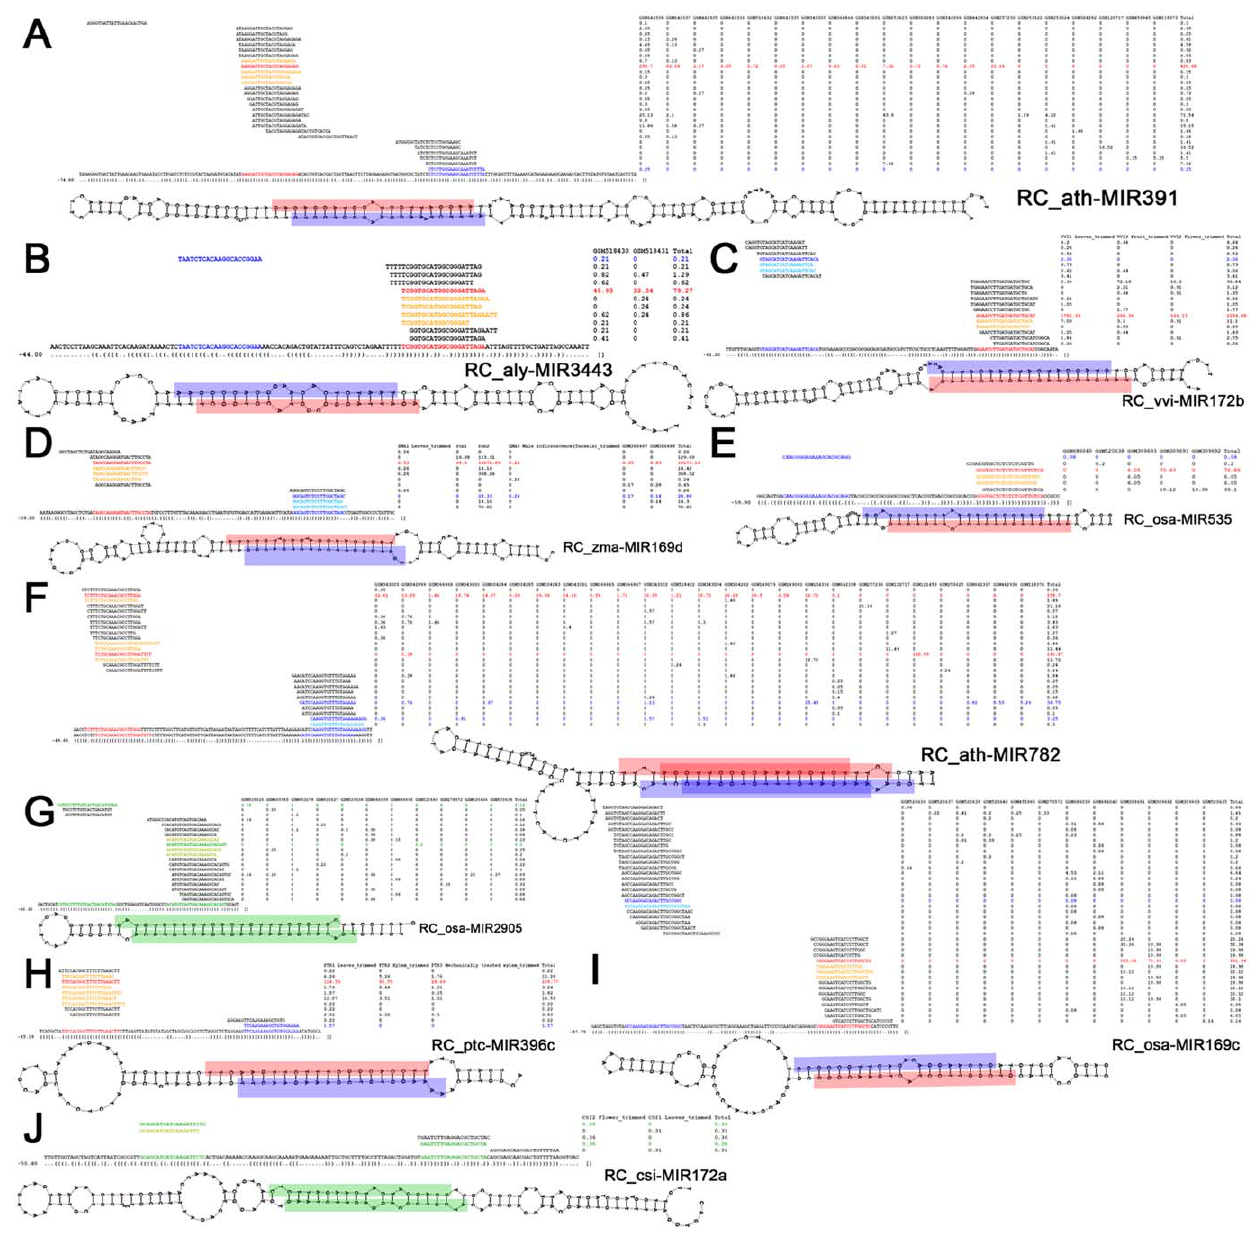
Figure 1. High-throughput sequencing (HTS) data- and structure-based identification of reverse complementary microRNAs (RC- miRNAs). (A) RC-ath-MIR391. (B) RC-aly-MIR3443. (C) RC-vvi-MIR172b. (D) RC-zma-MIR169d. (E) RC-osa-MIR535. (F) RC-ath-MIR782. (G) RC-osa- MIR2905. (H) RC-ptc-MIR396c. (I) RC-osa-MIR169c. (J) RC-csi-MIR172a. For all the panels, the short sequences perfectly mapped to the RC-miRNA precursors along with their normalized read counts in RPM (reads per million) are shown (see Table S1 for the small RNA HTS data sources and see Materials and Methods for read count normalization). The mature RC-miRNAs with significantly higher accumulation levels compared to the RC- miRNA* coordinates were highlighted in dark red color, and the other short sequences with identical 5 9 ends supporting the RC-miRNAs were in yellow. The RC-miRNA*s were in dark blue, and the other supporting sequences in light blue. For the RC precursors generating RC-miRNAs with indistinguishable accumulation levels on both arms, their mature RC-miRNAs were highlighted in green color and named as miRNA-5p (5 9 arm) and miRNA-3p (3 9 arm), respectively. The corresponding supporting sequences were in light green color. The RC-miRNAs and the star species were also indicated in the stem-loop structures of their precursors. The parenthesis-dot formed secondary structure expression along with the free energy, and the stem-loop structures were all predicted and generated by RNAshapes [17]. aly: Arabidopsis lyrata . ath: Arabidopsis thaliana . csi: Citrus sinensis . osa: Oryza sativa . ptc: Populus trichocarpa . vvi: Vitis vinifera . zma: Zea mays .